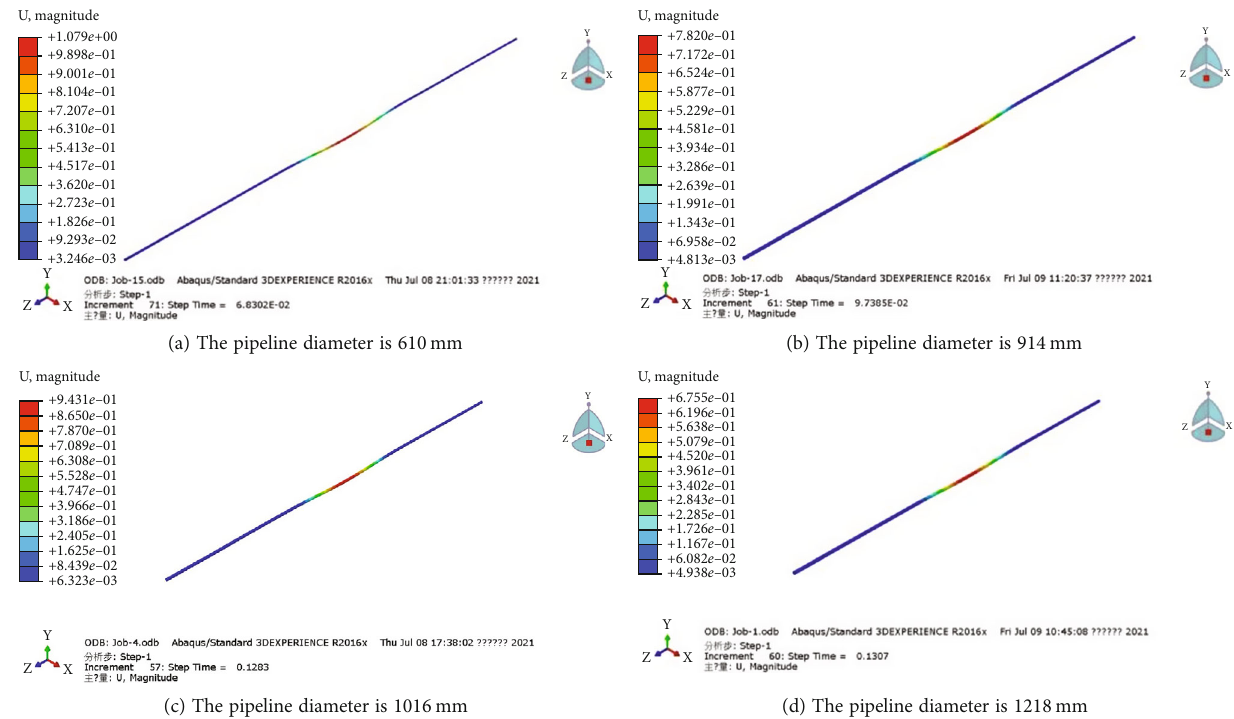
Figure 20: The pipeline ultimate deformation under di ff erent pipeline diameters.